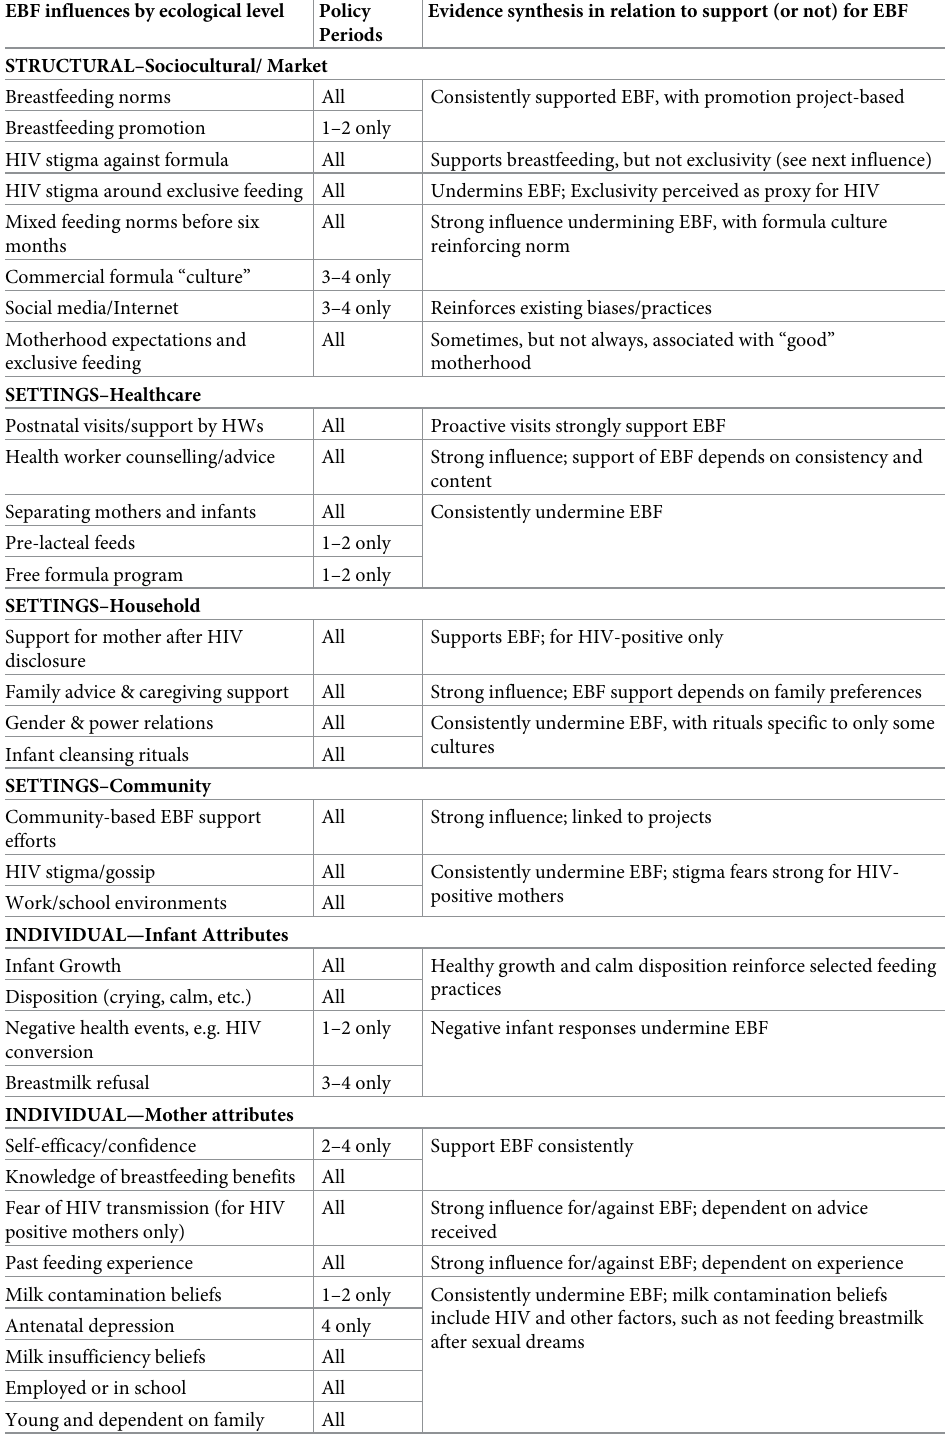
Table 5. Synthesis of key influences on EBF from 1980–2018 (based on S2 and S4